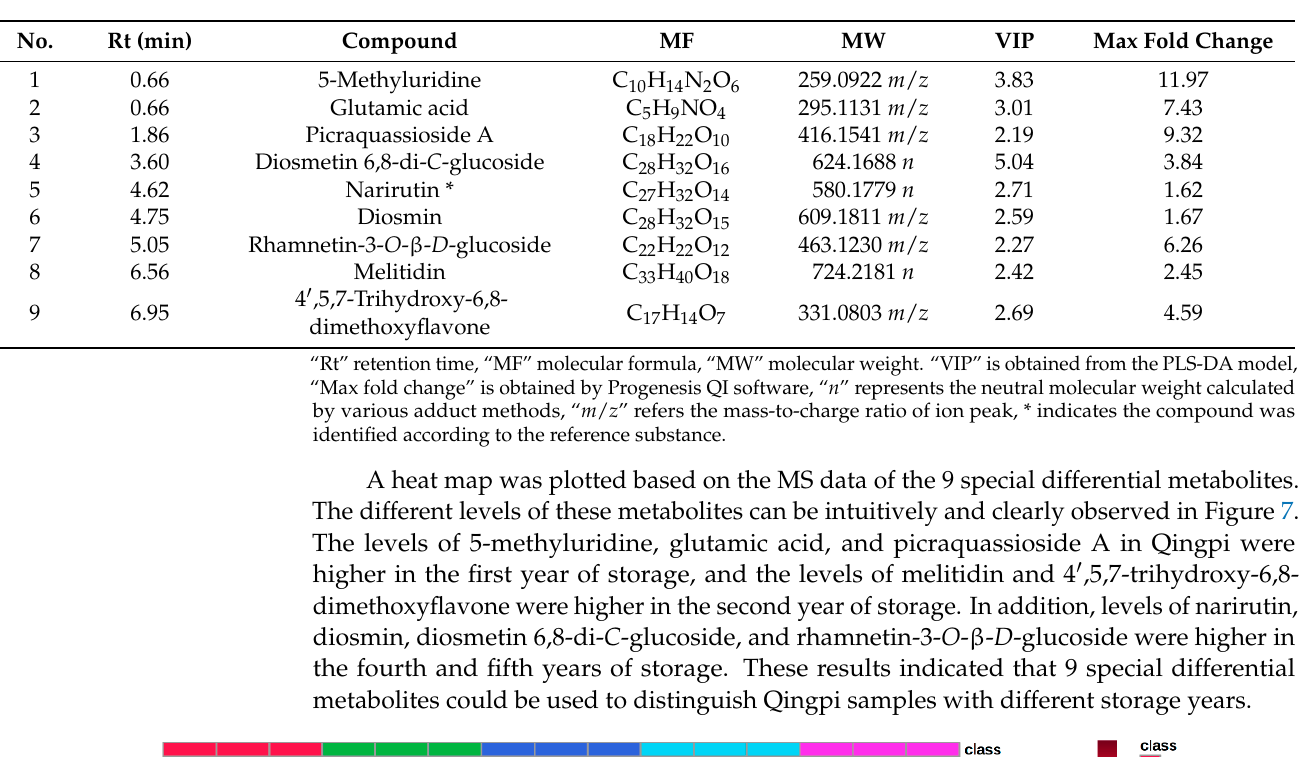
Table 3. Special differential metabolites screened from Qingpi samples stored for 1 to 5 years.